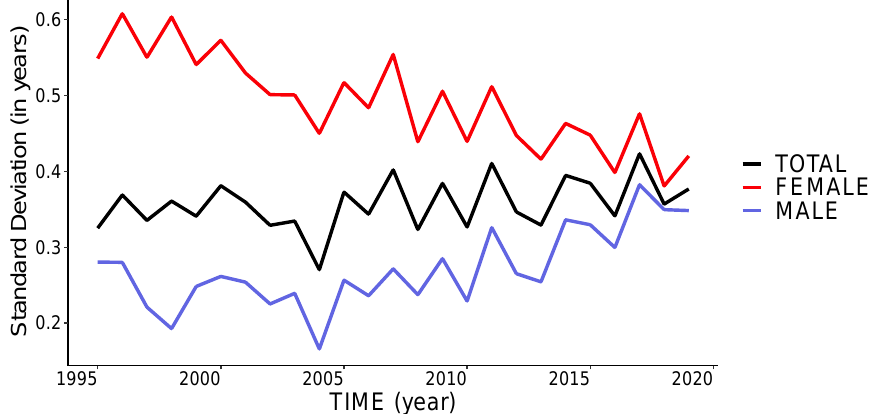
Figure 4. Geographical dispersion (NUTS-1 level) of life expectancy at age 65 by gender in Italy during 1995–2019. Source: